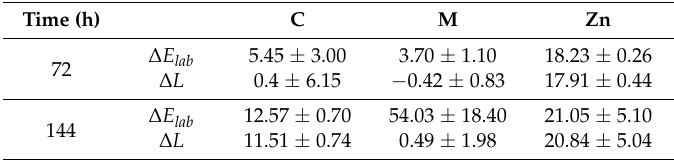
Table 2. The changes of colour of cod fillets after 72 h and 144 h of storage.